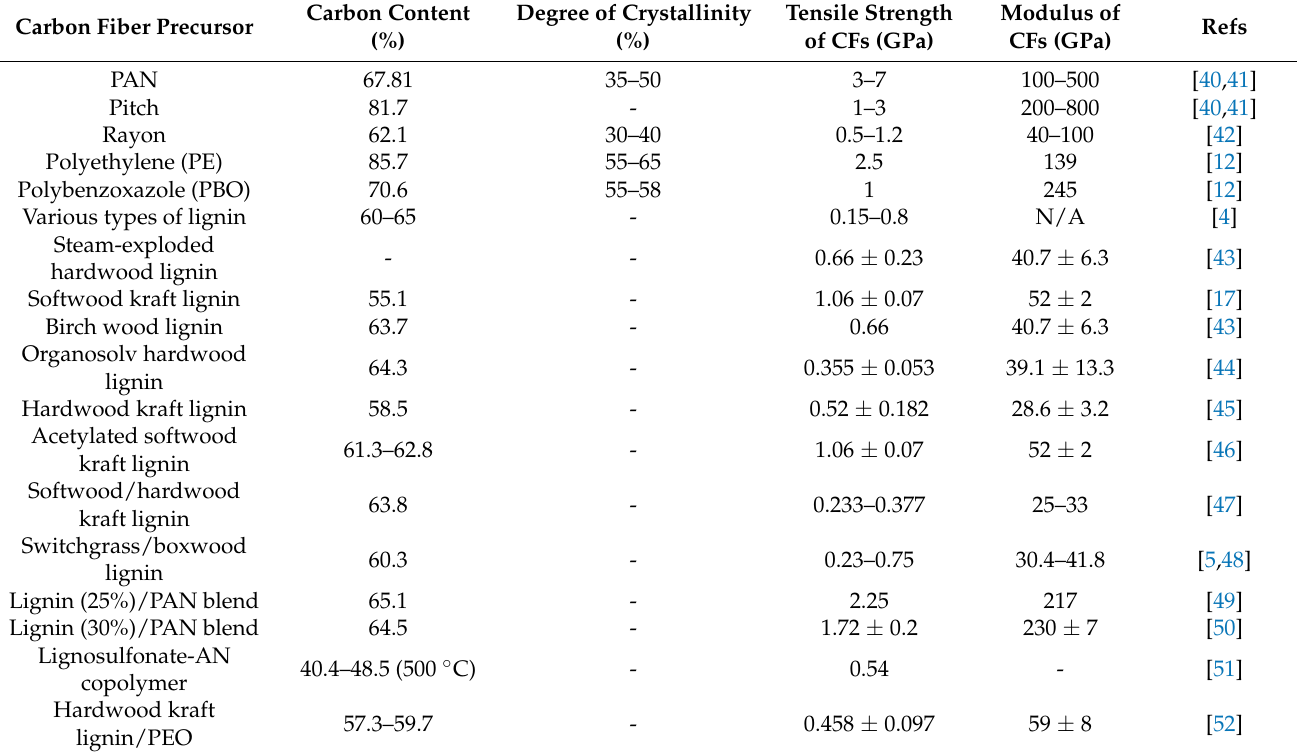
Table 1. Comparison of the different CF precursors and the properties of the final